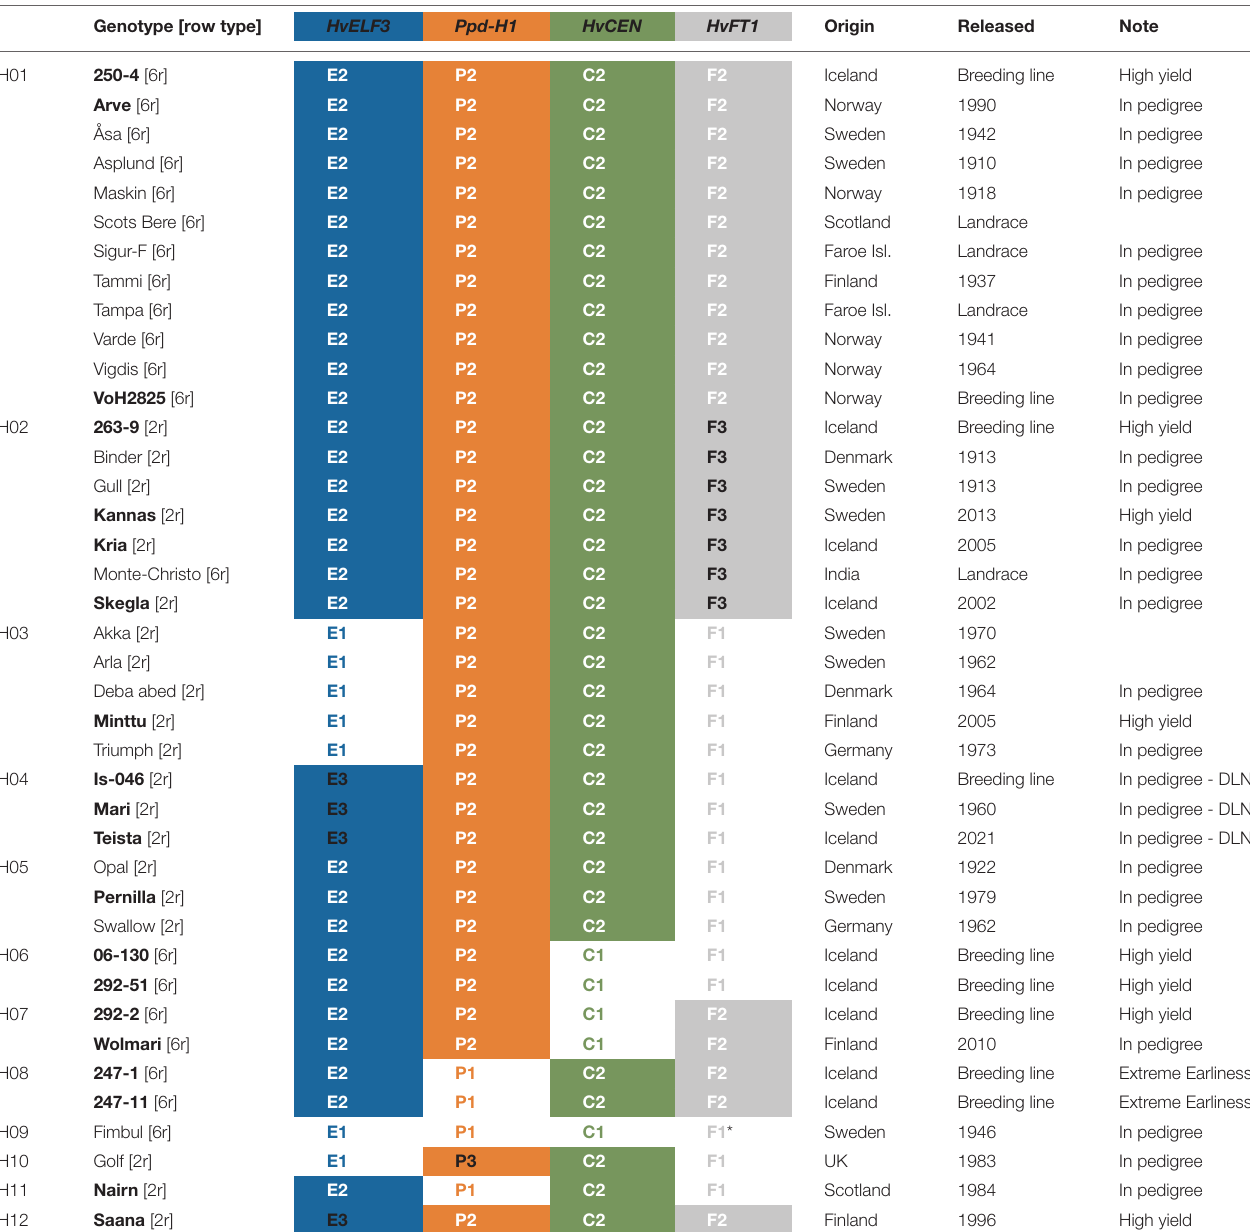
TABLE 1 | Genotypes with row type information, and their haplotypes of four re-sequenced flowering genes: HvELF3 (blue), Ppd-H1 (orange), HvCEN (green), and HvFT1 (grey), the geographic origin, release year, and note why they were included in the study. Genotype [row